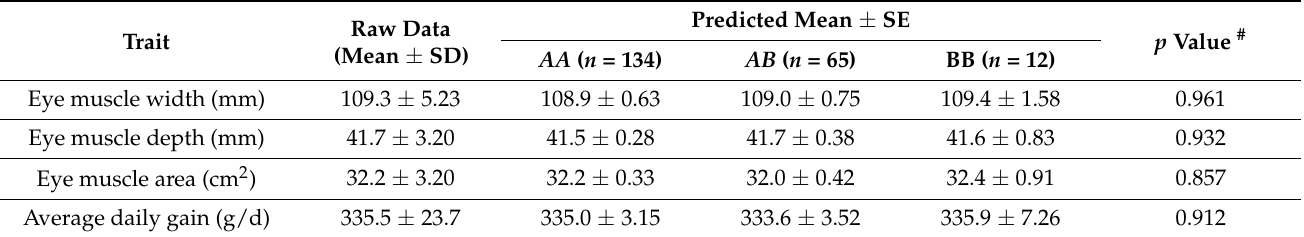
Table 1. Phenotypic data of New Zealand red deer between genotypes of the MSTN intron 1 region.